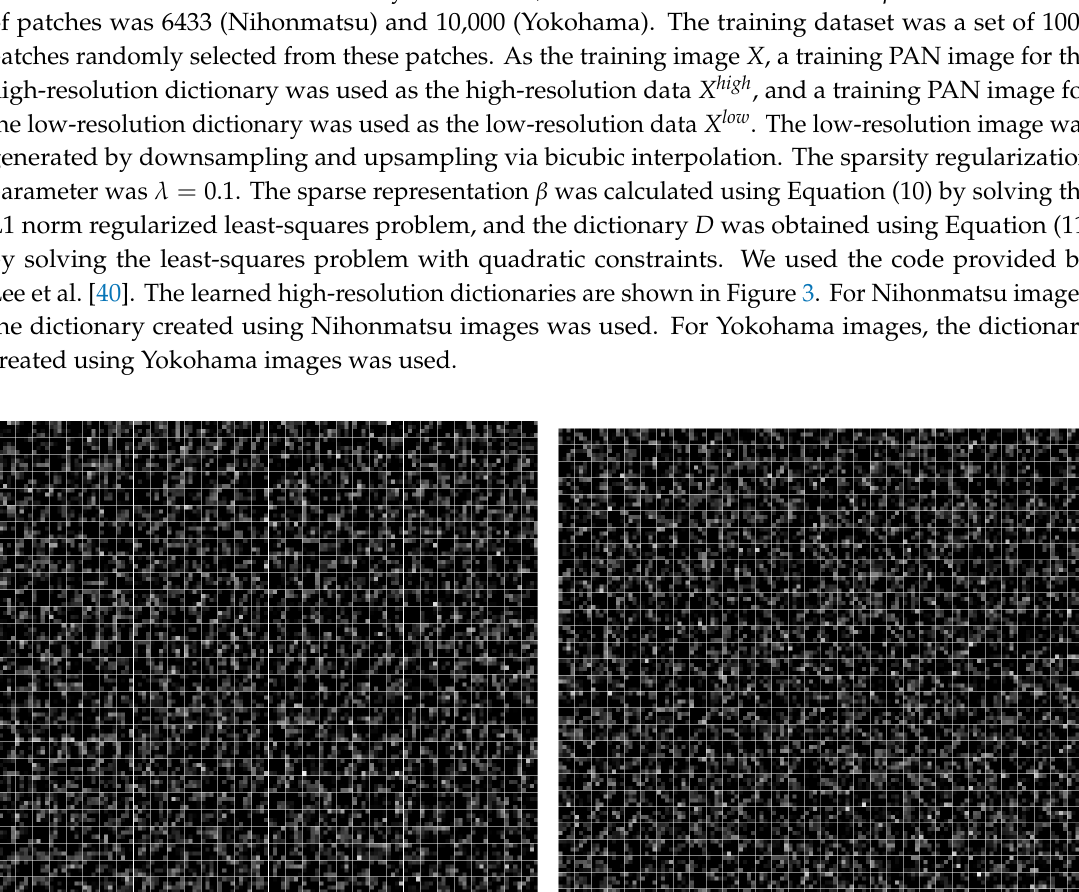
Table 2. The correction coefficient estimated by SCMP. Coefficient